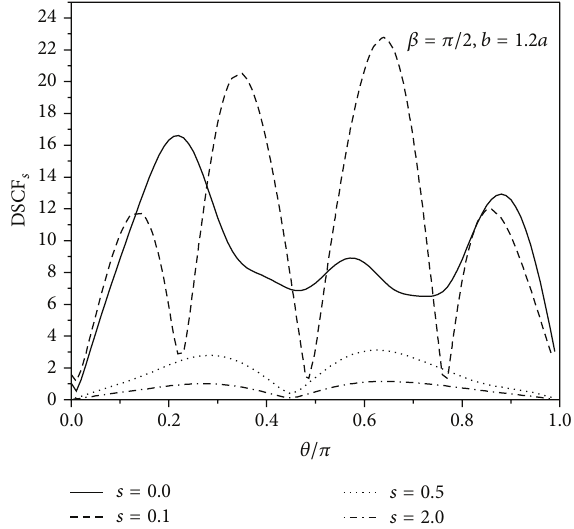
Figure 10: Surface effect on the distribution of DSCF along the middle hole for 𝛽 = 𝜋/2 and 𝑏 = 1.2𝑎 .